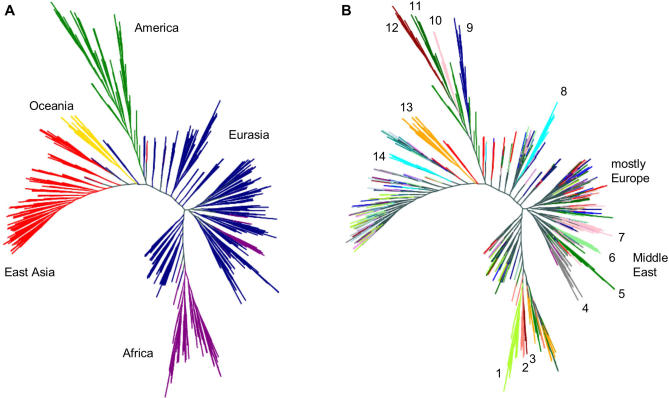
Neighbor-Joining Trees Depicting the Genetic Relationships of 1,040 Individuals from 51 World Populations Collected by the CEPH-HGDP(A) Individuals are color coded according to which of five major geographic regions of the globe they are collected from.(B) Individuals are color coded according to which of the 51 populations they are associated with (1: Biaka Pygmy, 2: San, 3: Mbuti Pygmy, 4: Druze; 5: Bedouin, 6: Mozabite, 7: Palestinian, 8: Kalash, 9: Pima, 10: Columbian, 11: Karitiana, 12: Surui, 13: New Guinea, 14: Yakut).